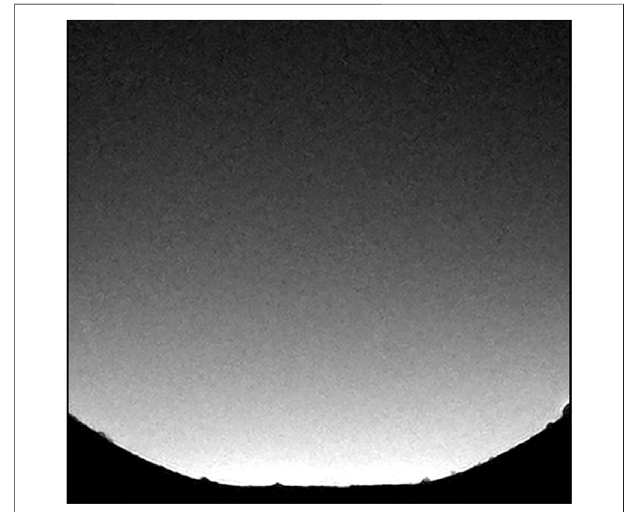
FIGURE 1 | The control scan of a basketball fi lled with dilute nickel chloride that was used to fi nd the power function (i.e., normalization curve) for normalizing the intensity gradient in scans of the